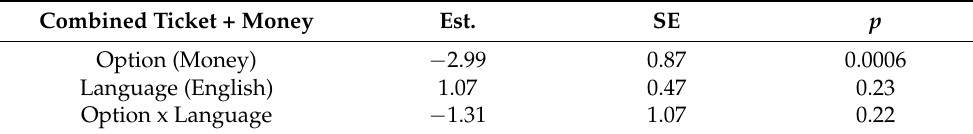
Table 9. Regression results for Ticket/Money loss tasks.